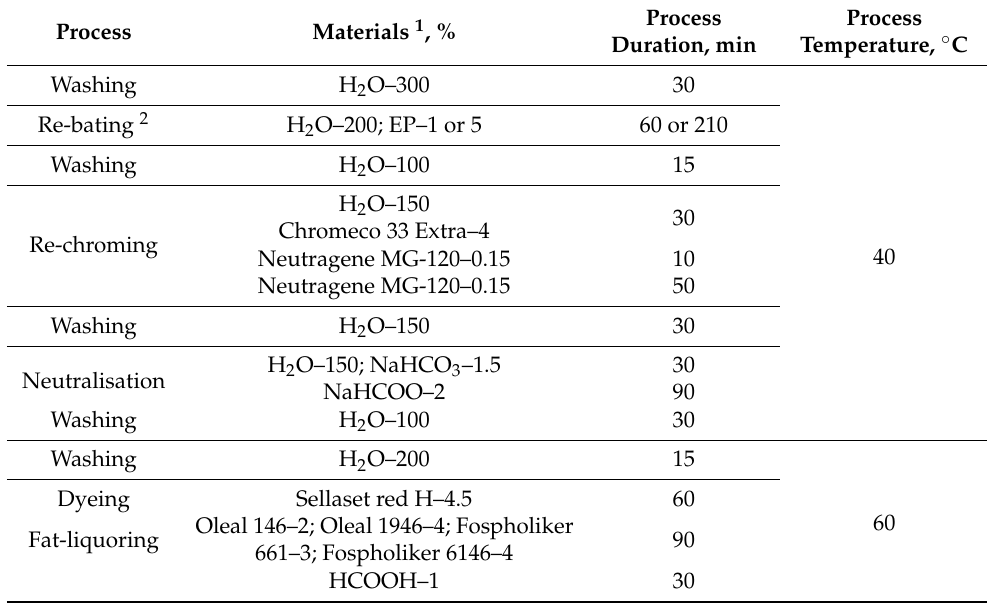
Table 1. Technological